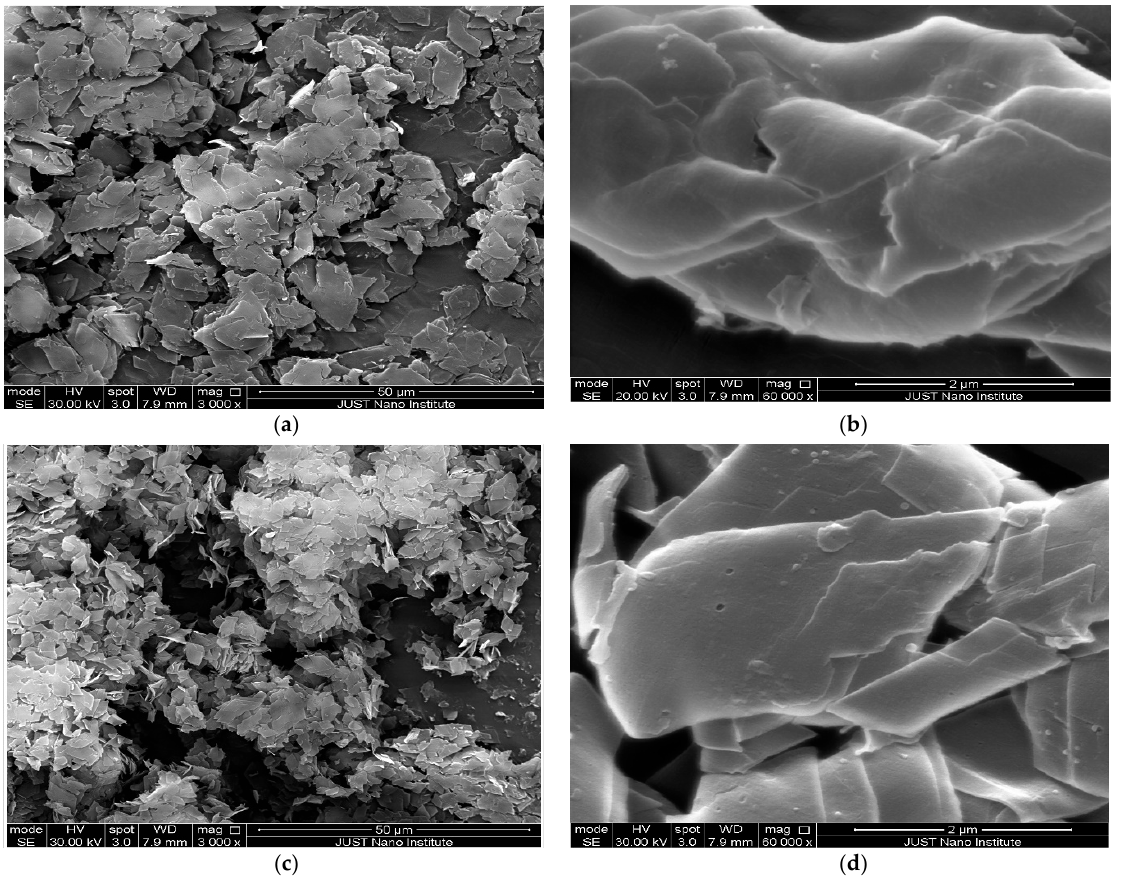
Figure 8. SEM images of: ( a ) curcumin ‐ loaded DPC cross ‐ linked nanosponge (3000×); ( b ) curcumin ‐ loaded DPC cross ‐ linked nanosponge (60,000×); ( c ) curcumin ‐β‐ cyclodextrin complex (3000×); ( d ) curcumin ‐β‐ cyclodextrin complex (60,000×).